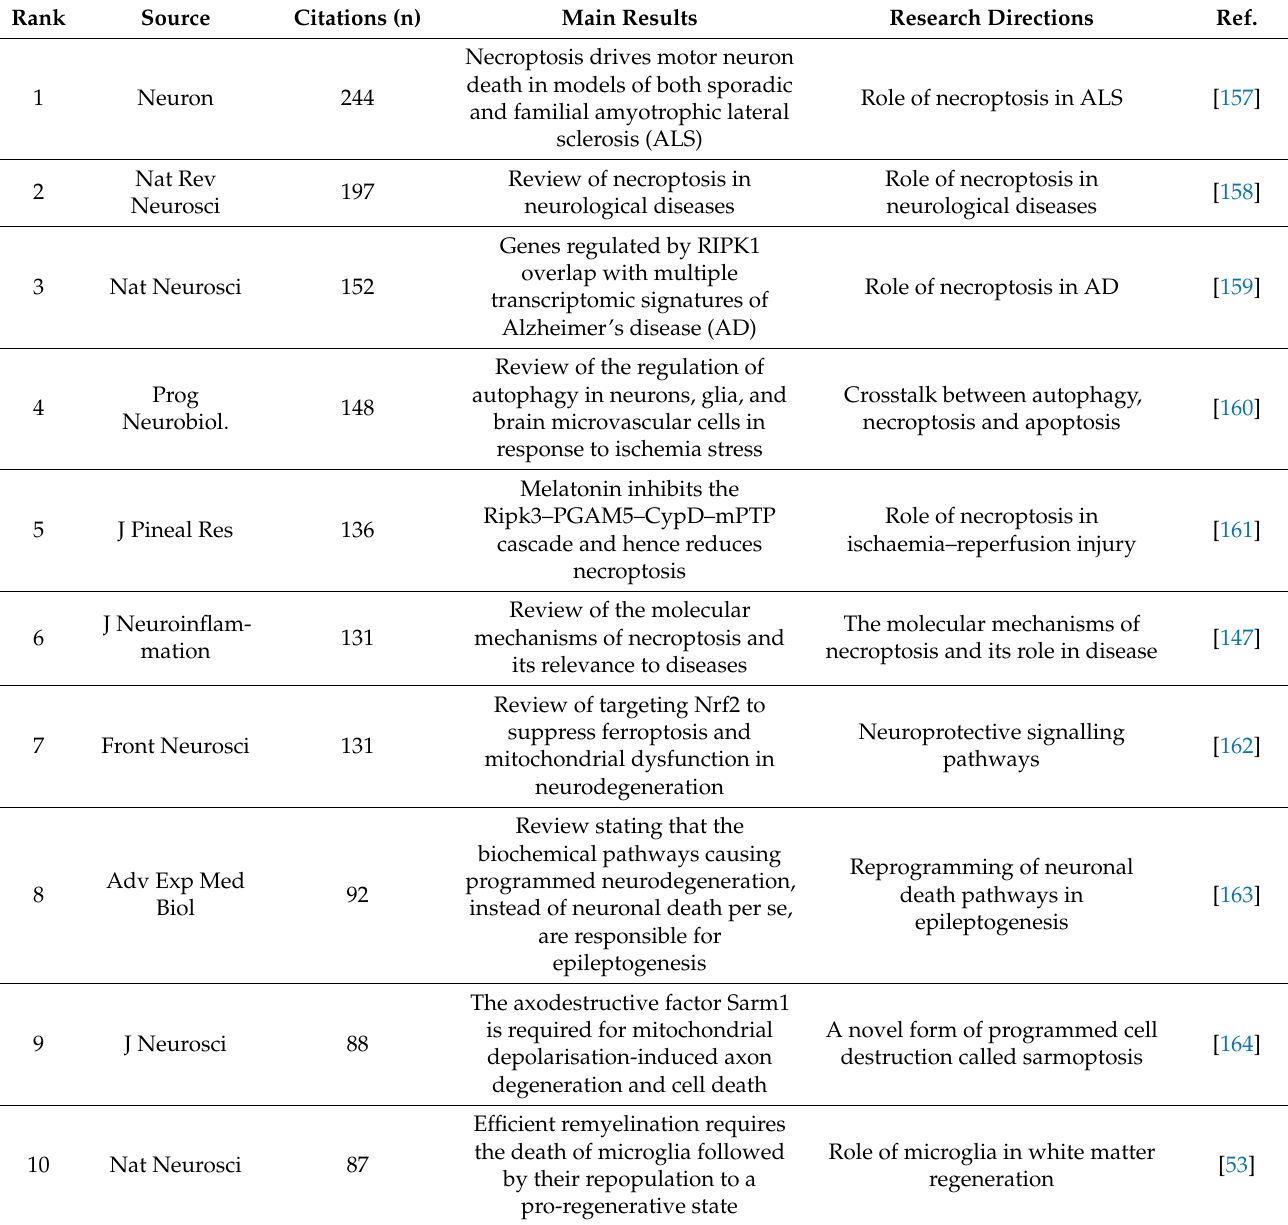
Table 3. Top 10 necroptosis-related articles with the highest citations in the field of neuroscience.